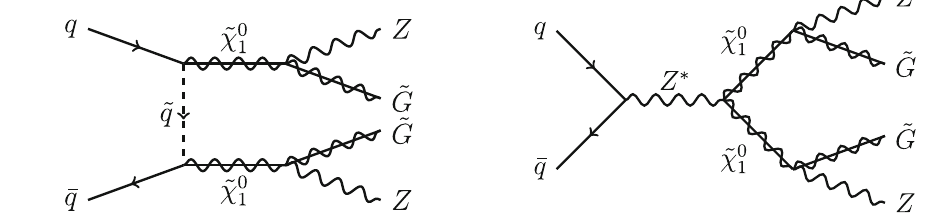
Table 1 Non-zero amplitudes for A ( j , m ) → Z ( 1 ,λ 1 ) B ( j (cid:2) ,λ 2 )